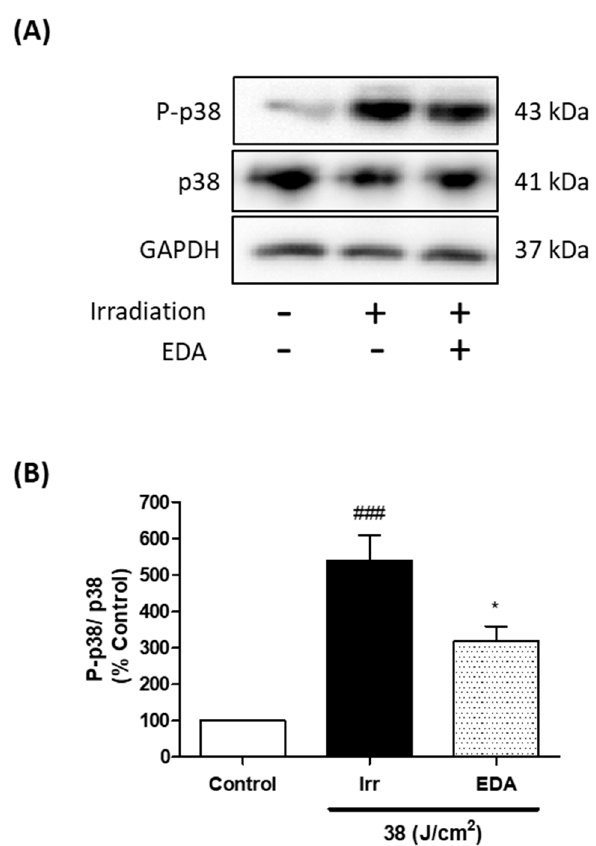
Figure 4. Phosphorylation of p38 in HDF exposed to artificial blue light and EDA pre-treatment. Phosphorylation of p38 was evaluated by WB. Cells were incubated with EDA 0.1 mg / mL for 24 h, irradiated and proteins extracted 1 h after irradiation. Representative immunoblots ( A ) and quantification plot ( B ) are shown ( n ≥ 3). Data were expressed as % of control cells. Data are shown as mean ± SEM. ### p < 0.001 vs control; * p < 0.05 vs irradiated cells.